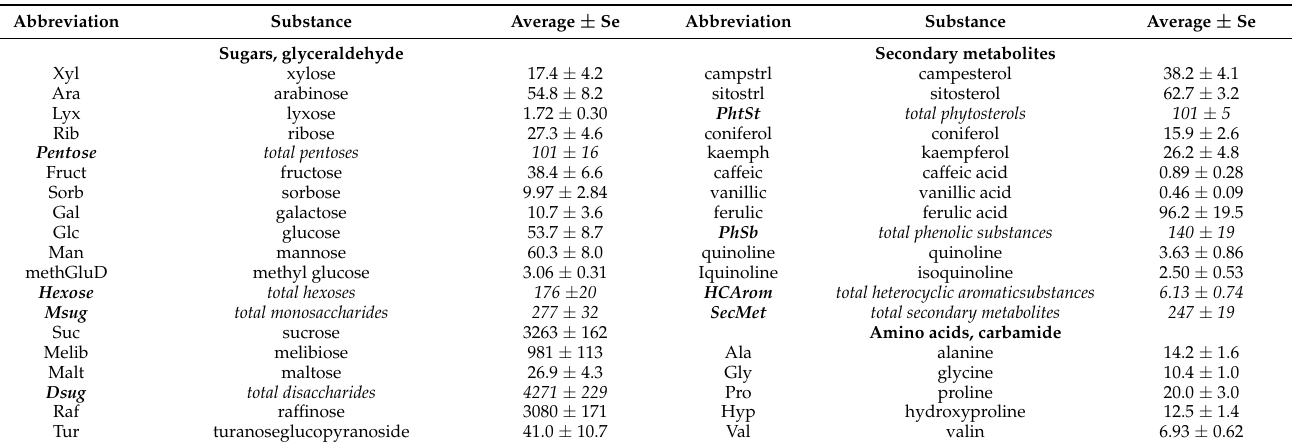
Table 1. The amount of biologically active substances presented as average values (in n.u.) from all studied VIR flax genetic collection